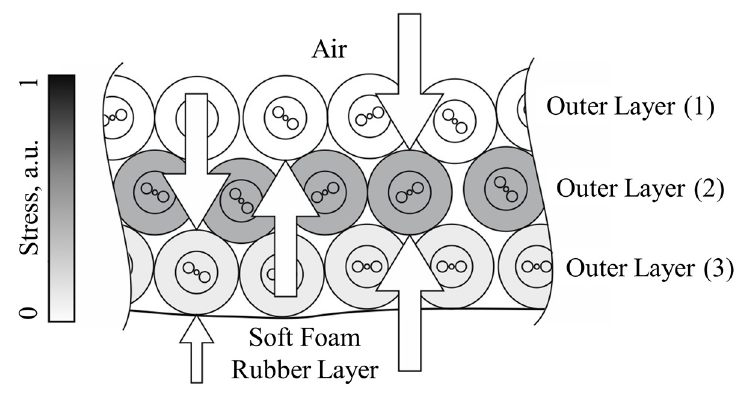
Figure 6. A schematic fragment of the studied fiber (FUT) cross-section on the transport coil.